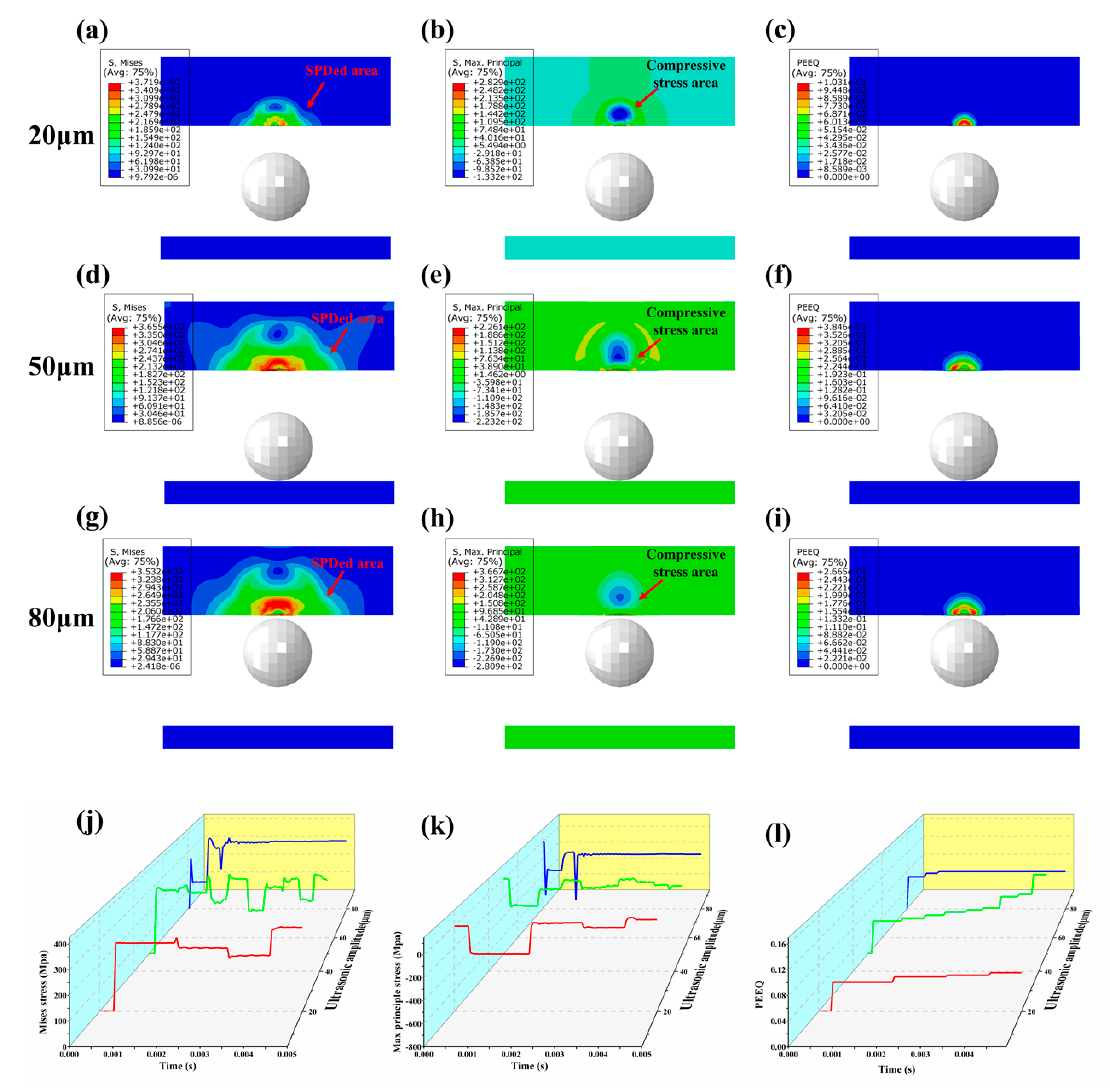
Figure 11. Effect of ultrasonic amplitude on von Mises stress, maximum principal stress, and plastic strain of 316L stainless steel during ultrasonic shot peening process: ( a – c ) von Mises stress, maximum principal stress, and plastic strain of 316L stainless steel with USP amplitude of 20 µ m, respectively; ( d – f ) von Mises stress, maximum principal stress, and plastic strain of 316L stainless steel with USP frequency of 50 µ m, respectively; ( e – i ) von Mises stress, maximum principal stress, and plastic strain of 316L stainless steel with USP frequency of 80 µ m, respectively; ( i – l ) comparison of von Mises stress, maximum principal stress, and plastic strain of 316L stainless steel with USP frequency of 20 µ m, 50 µ m and 80 µ m, respectively.